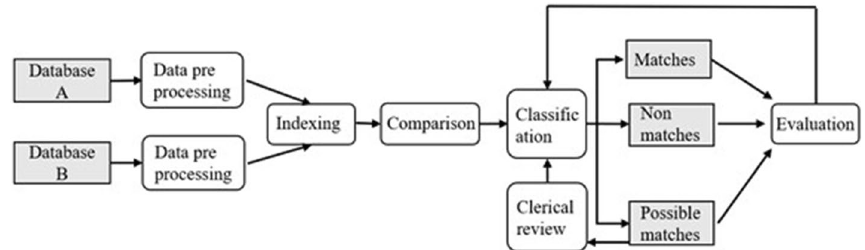
Fig. 1 Outline of the general record linkage